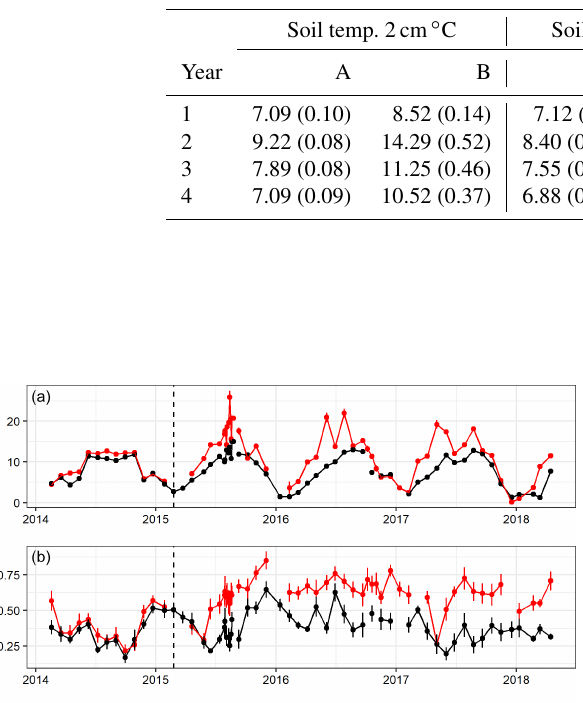
Figure 3. Monthly total rainfall measured after felling in each area in Harwood Forest atop the 30m tower in the mature spruce stand (area A; black) and on the ground in the clear-fell site (area B; red). Measurements only started in area B in June